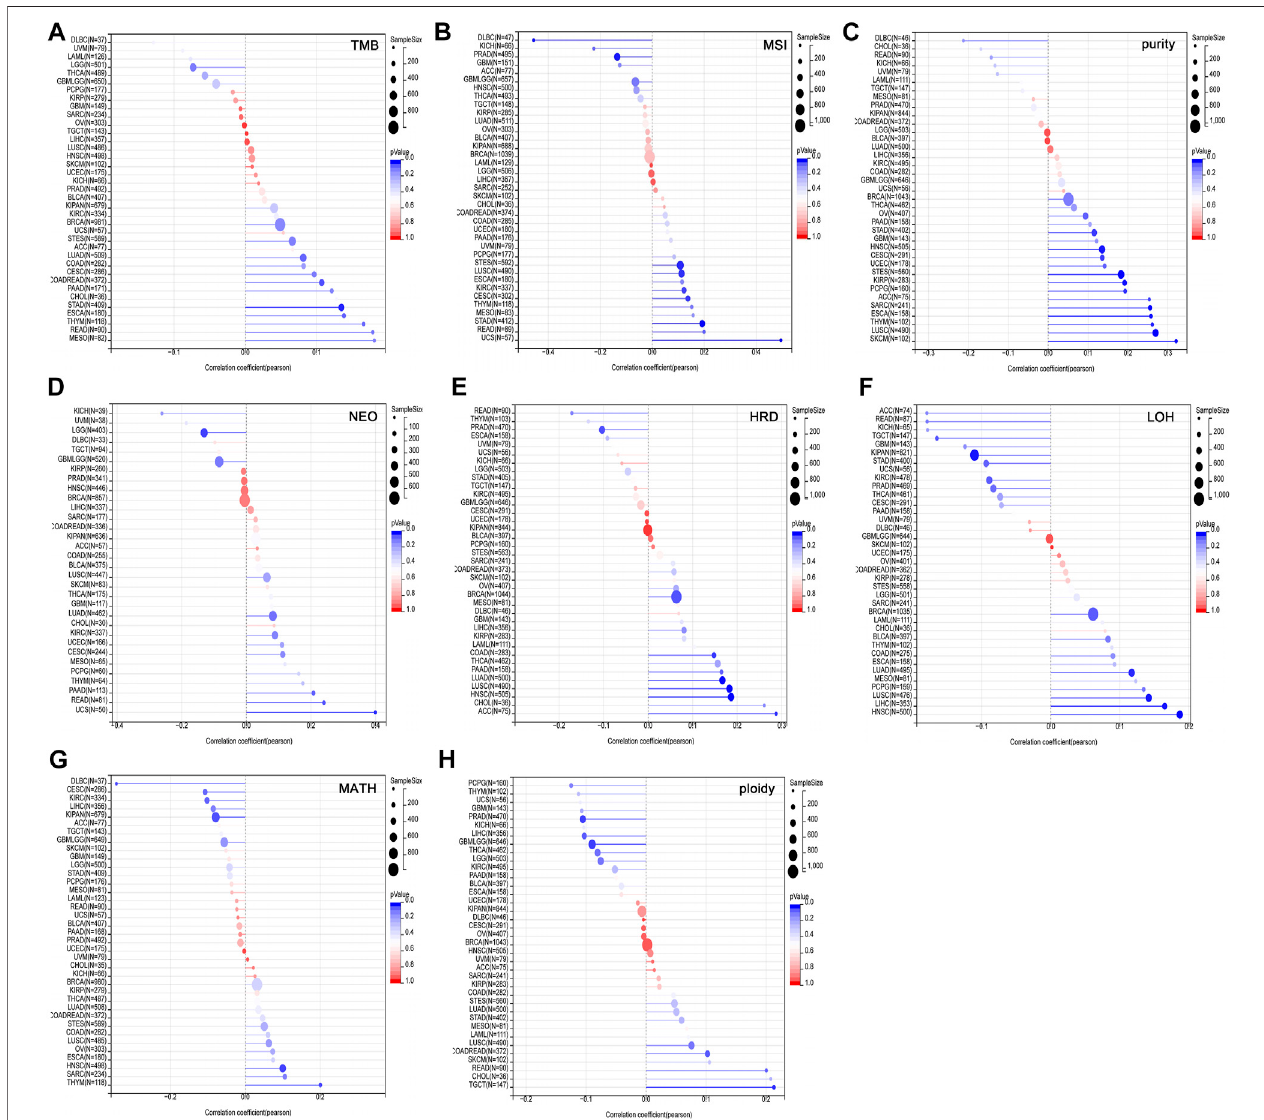
FIGURE5| CorrelationofUSP45withtumor heterogeneity indifferenttypes oftumors.Tumor heterogeneity includestumor mutationburden (TMB),microsatellite instability (MSI), tumor purity, neoantigen (NEO), homologous recombination de fi ciency (HRD), loss of heterozygosity (LOH), mutant-allele tumor heterogeneity (MATH), tumor ploidy. The correlation between USP45 and TMB (A) , MSI (B) , tumor purity (C) , NEO (D) , HRD (E) , LOH (F) , MATH (G) , and ploidy (H) were analyzed based on TCGA database.